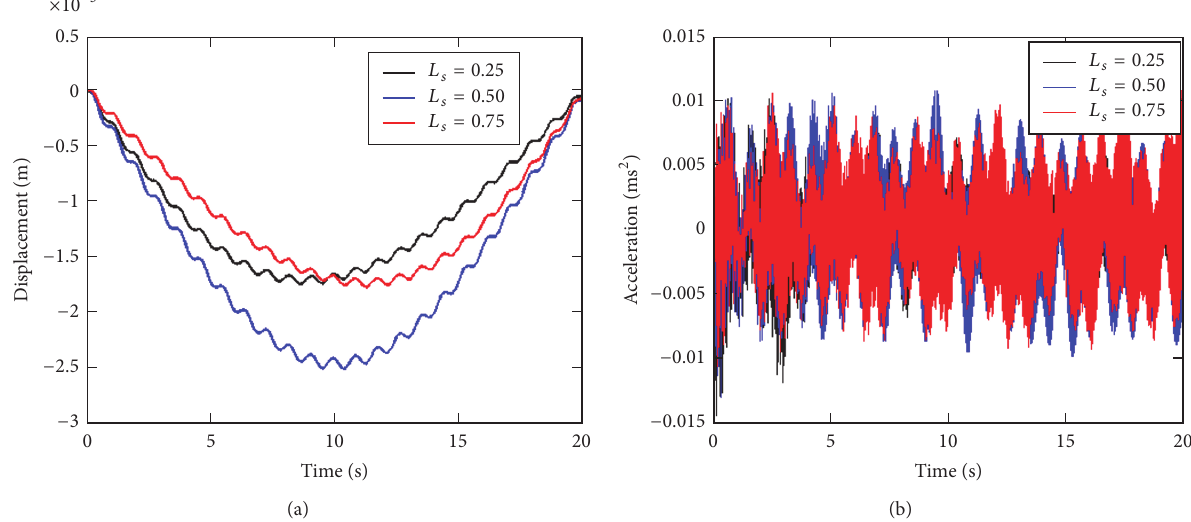
Figure 21: Undamaged responses of different sensor location scenarios with V = 1 m/s, 𝑚 𝑚 = 200 Kg, and 𝐿 𝑑 = 0.4 : (a) is displacement responses and (b) is acceleration responses.